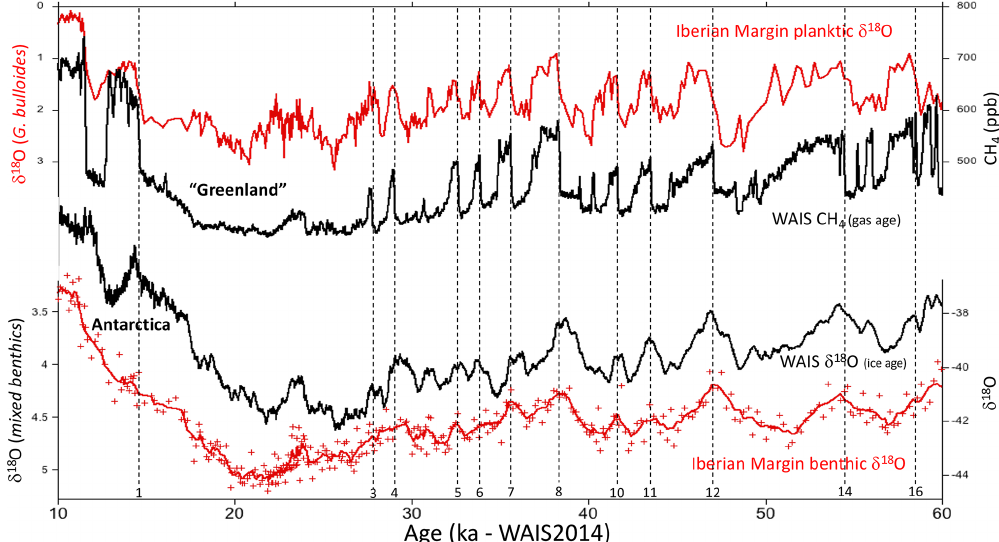
Figure 2. Comparison of Iberian margin δ 18 O records and polar ice cores. Top panel: planktic δ 18 O from core MD95-2042 (Shackleton et al., 2000) compared with CH 4 from the West Antarctic Ice Sheet (WAIS) Divide ice core from Antarctica (WAIS Divide Project Members, 2015); Bottom panel: benthic δ 18 O in core MD95-2042 compared with the δ 18 O record of the WAIS Divide ice core (WAIS Divide Project Members, 2015). Vertical dashed lines are drawn at the abrupt transitions from cold stadials to warmer interstadial conditions in Greenland and are numbered at the bottom of the figure. Note that the phasing of planktic and benthic δ 18 O is the same as that inferred from the CH 4 and δ 18 O in the WAIS Divide ice core. This pattern has been interpreted as being indicative of a thermal bipolar